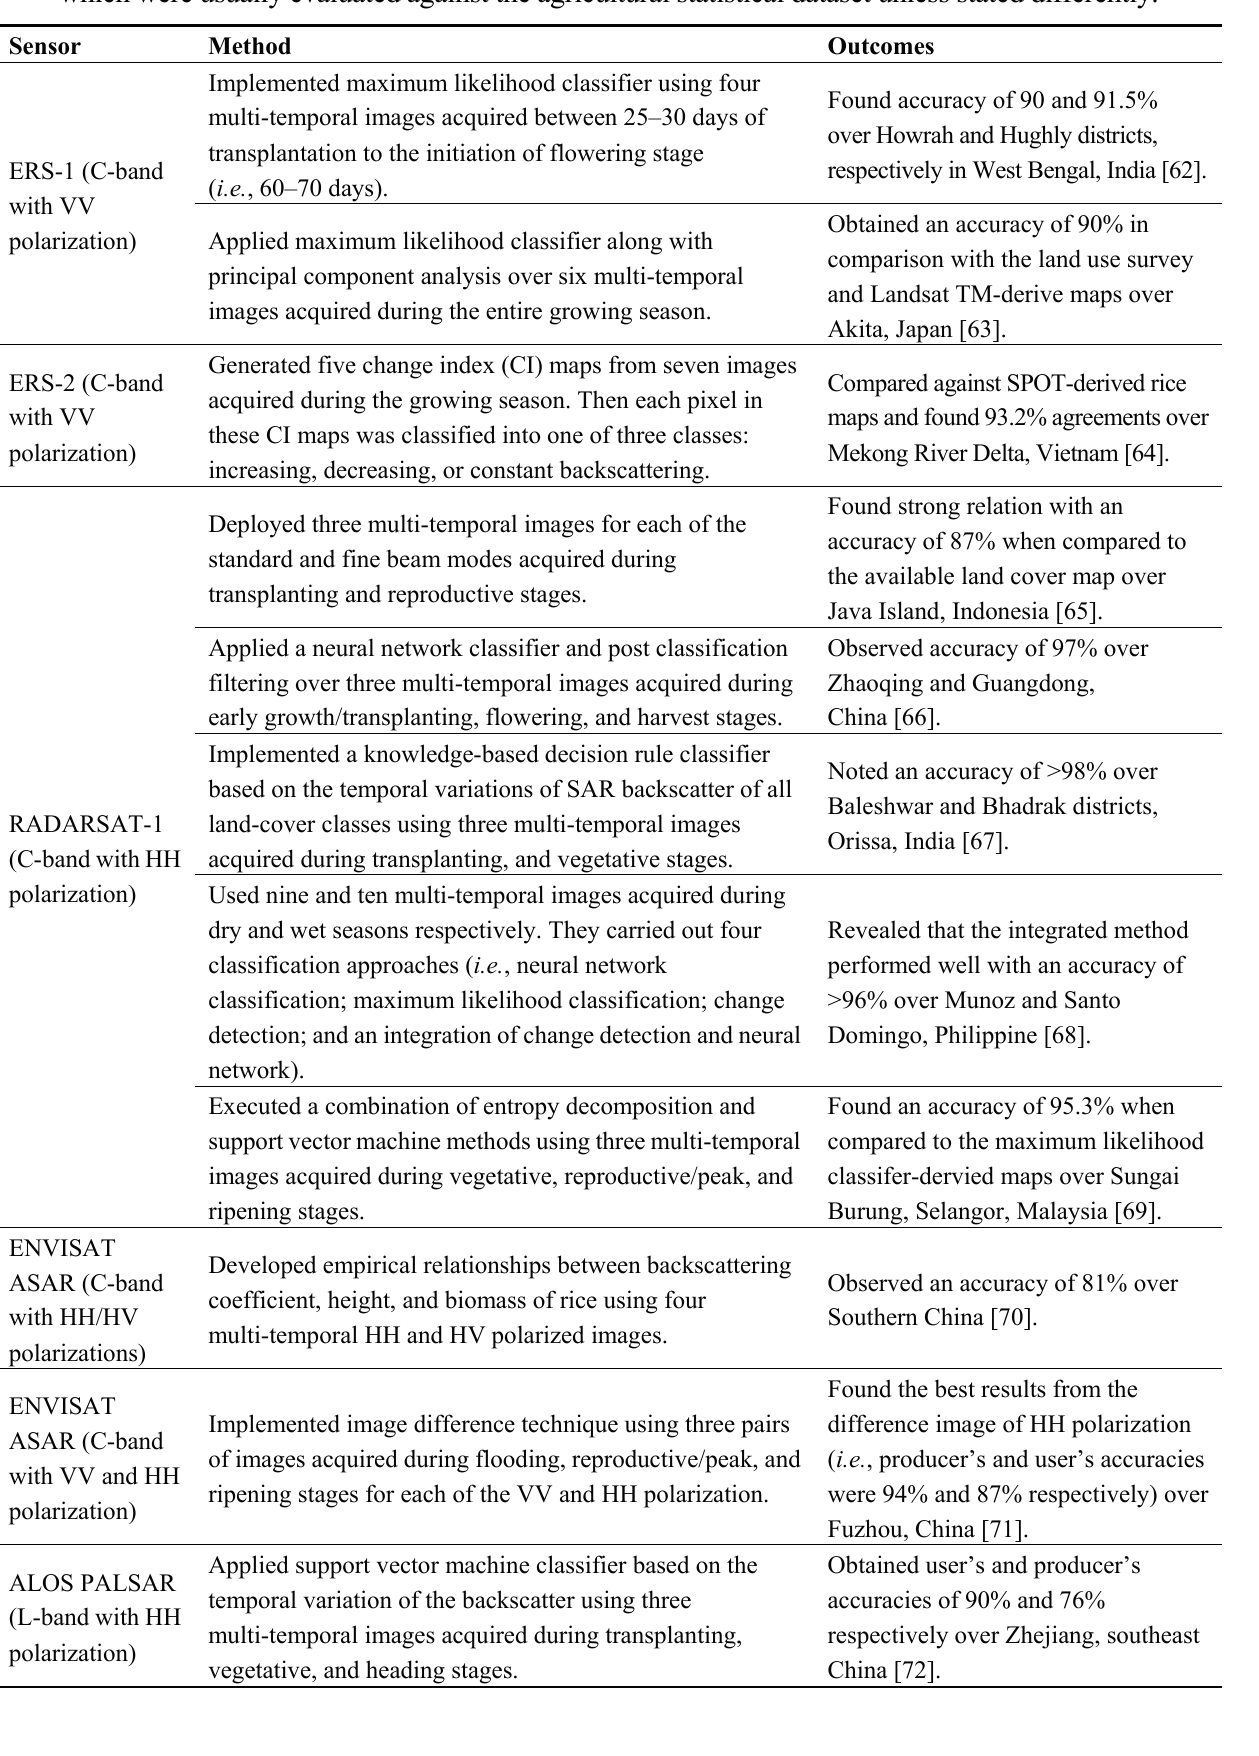
Table 3. Examples of microwave remote sensing-based methods used for rice area mapping, which were usually evaluated against the agricultural statistical dataset unless stated